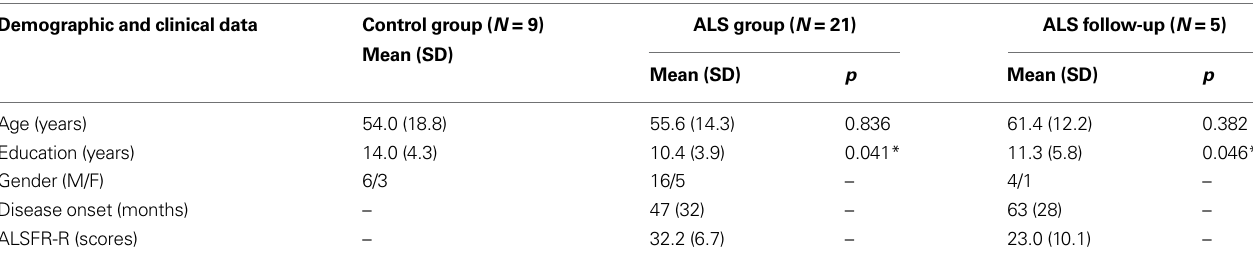
Table 1 | Demographic and clinical data in ALS and control group. Demographic and clinical